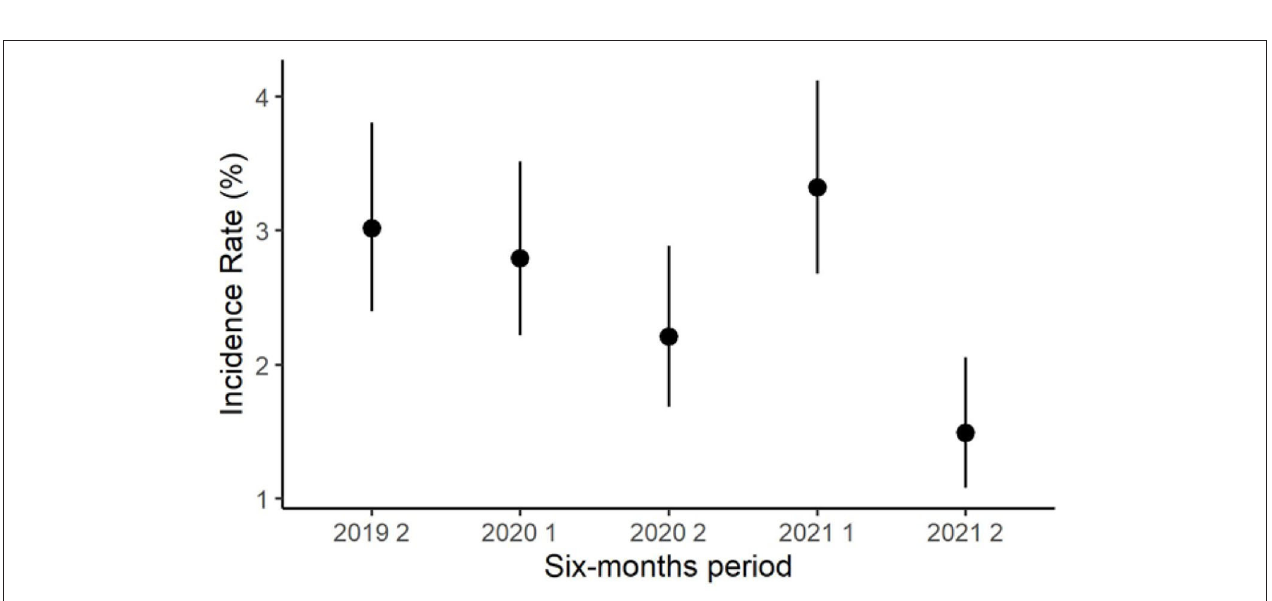
FIGURE 3 | Trend of the semiannual herd-level incidence rate of S. agalactiae in dairy herds of the Emilia-Romagna region, 2019–2021.